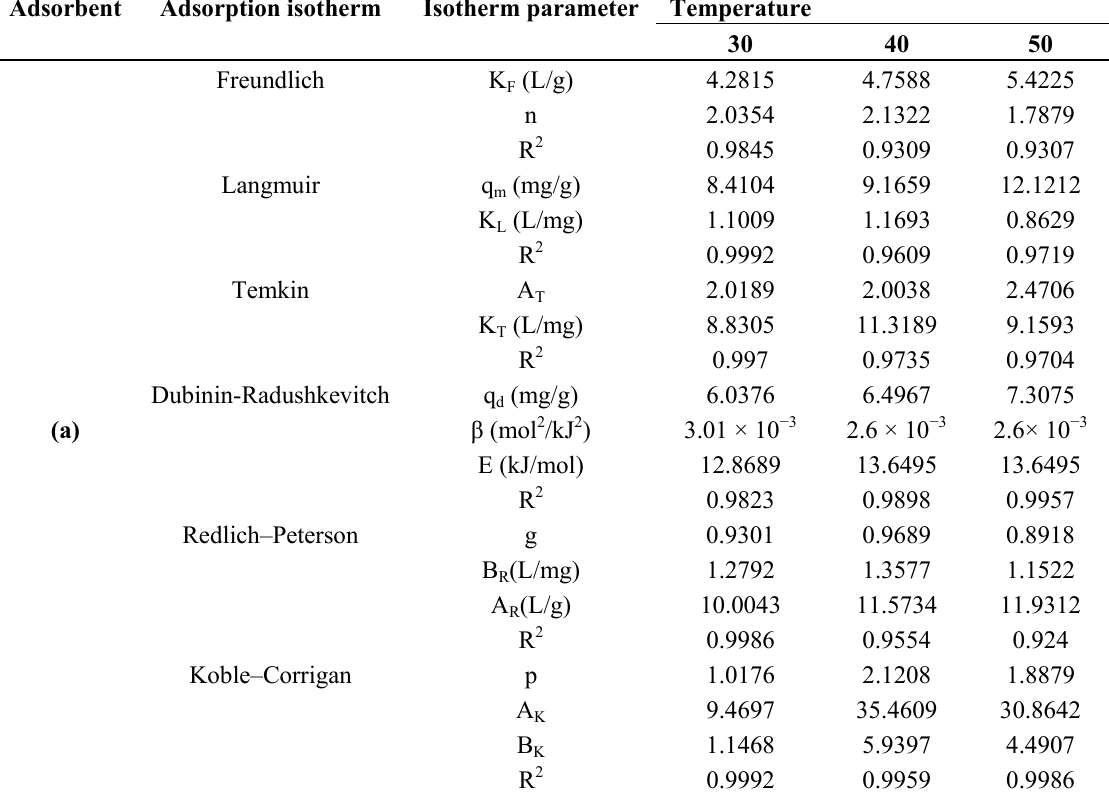
Table 2. Isotherm constants and correlation coefficient of determination for various ( b ) and MCM-TDI-C4S ( c